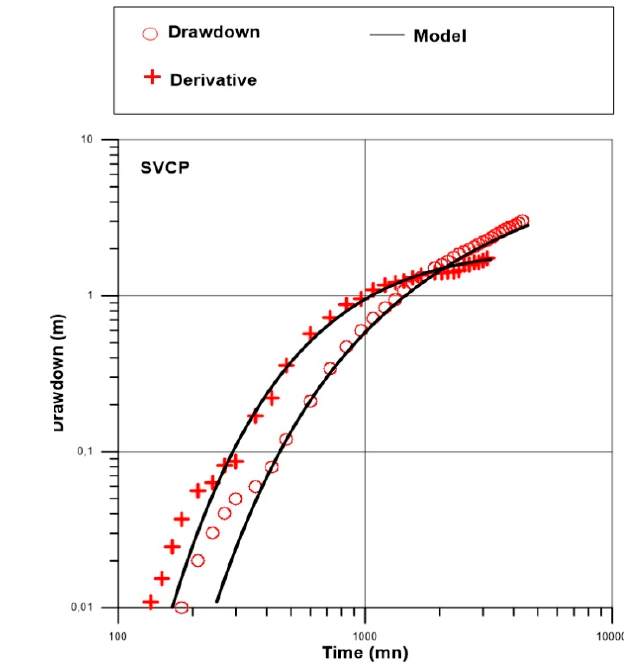
Figure 16. Interpretation of pumping test SVCF/SVCP: diagnostic plot ( left ) and data superimposed with a fitted Theis model with an infinite linear boundary located at 250 m from the pumping ( right ).